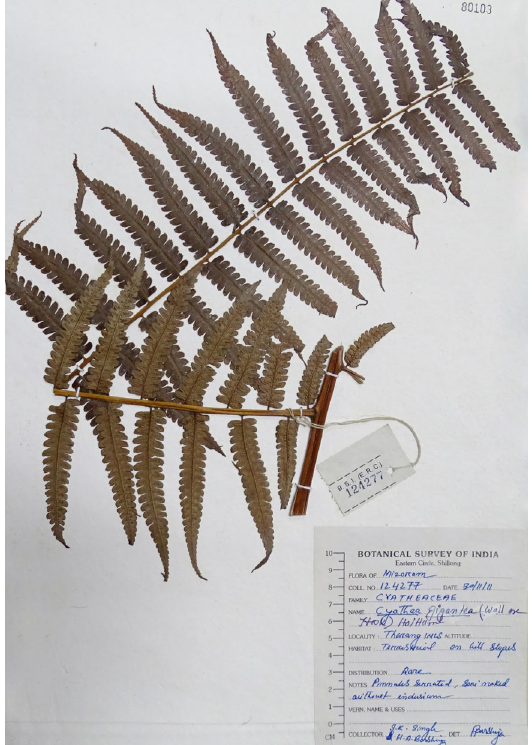
Image 15. Cyathea brunoniana